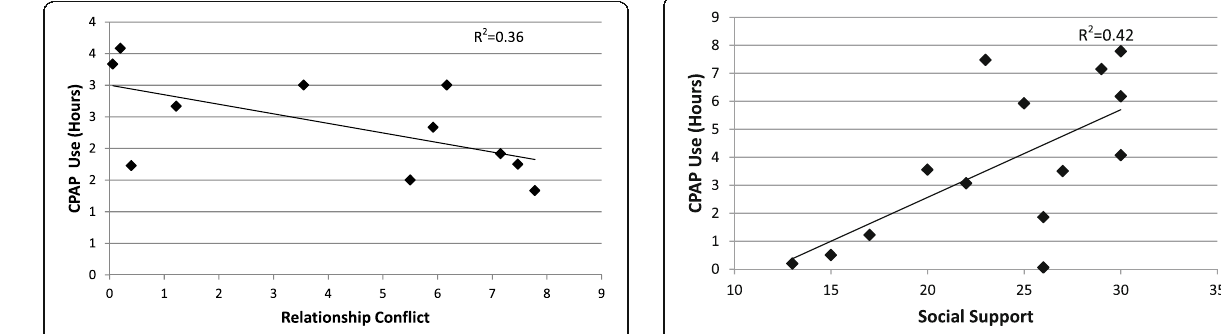
Fig. 1 Relationship conflict is associated with lower CPAP use Fig. 2 Social support is associated with higher CPAP